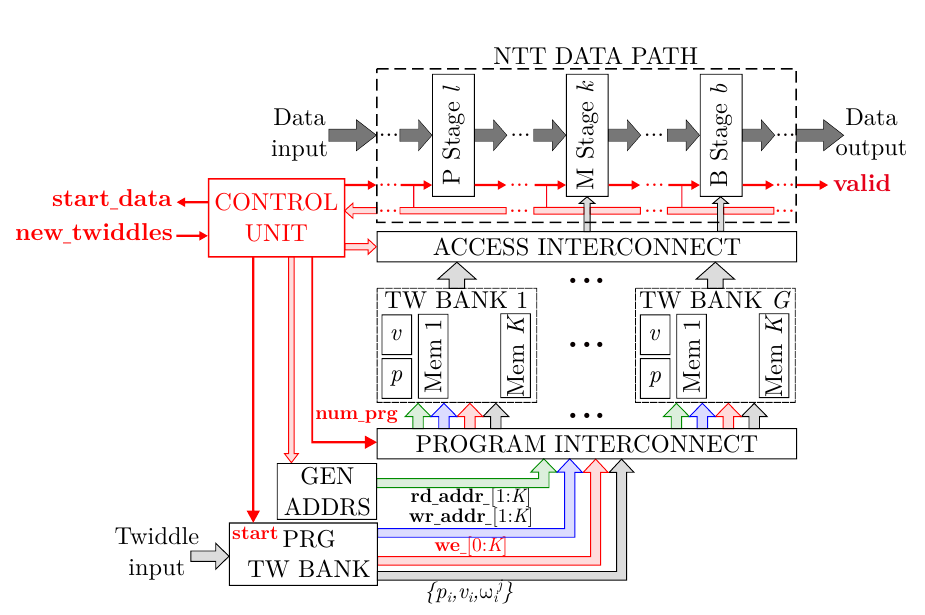
Figure 2: Number Theoretical Transform (NTT) flow. Schematic for w =